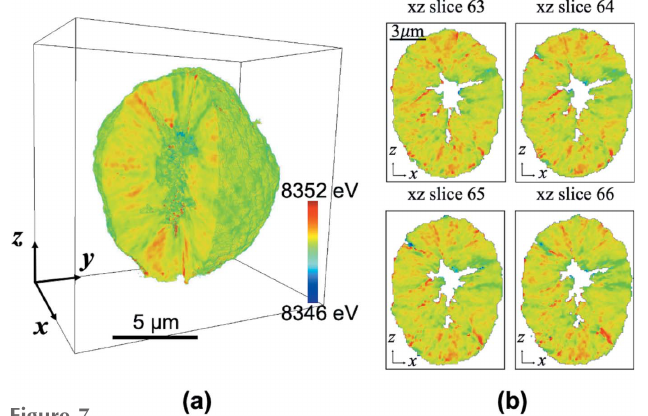
Figure 7 White-line peak position map of a NMC811 particle. ( a ) 3D rendering of the white-line peak position distribution. ( b ) Four slices parallel to the xz plane show slow variation in the y direction